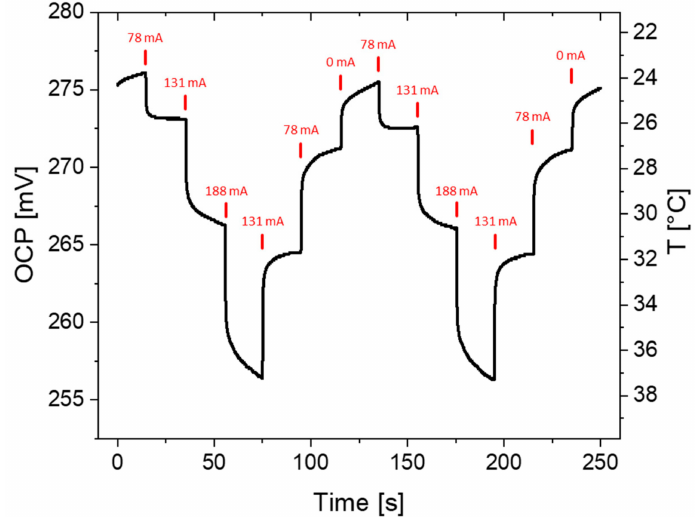
Figure 2. Open circuit potential (OCP) measured over time at a flattened wire substrate in a solution of 5 / 5 mM ferro / ferricyanide and 1.0 M KCl. The applied AC was varied in time intervals of 20 s (indicated by red marks), and the change in OCP with the corresponding temperature was